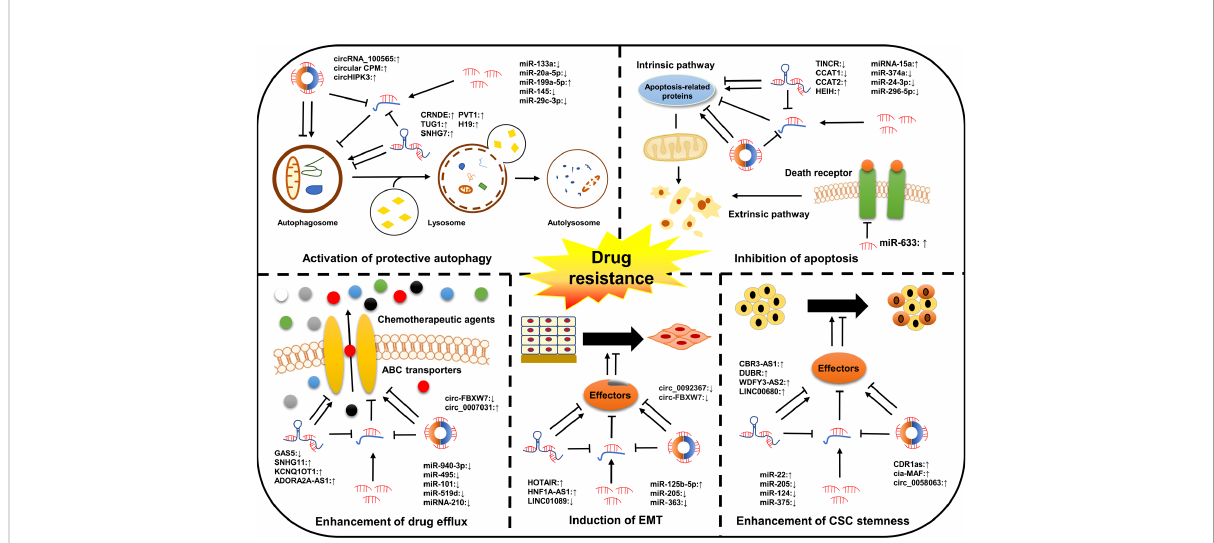
FIGURE 2 Classical mechanisms of ncRNAs in cancer drug resistance. The dysregulation of ncRNAs contributes to the development of cancer drug resistance by modulating multiple cellular processes of cancer cells, such as drug ef fl ux, cell apoptosis, autophagy, and EMT as well as the acquisition of CSC